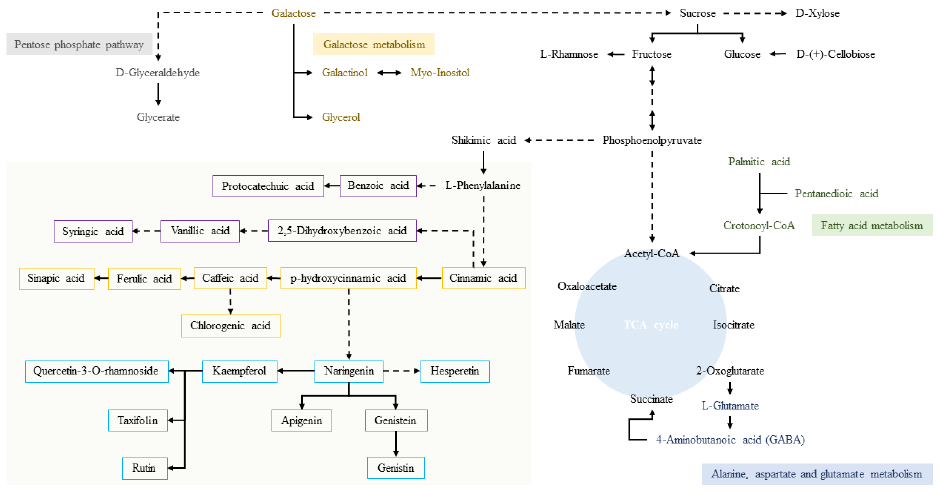
Figure 9. Major metabolic networks of APM and ATG leaves in different